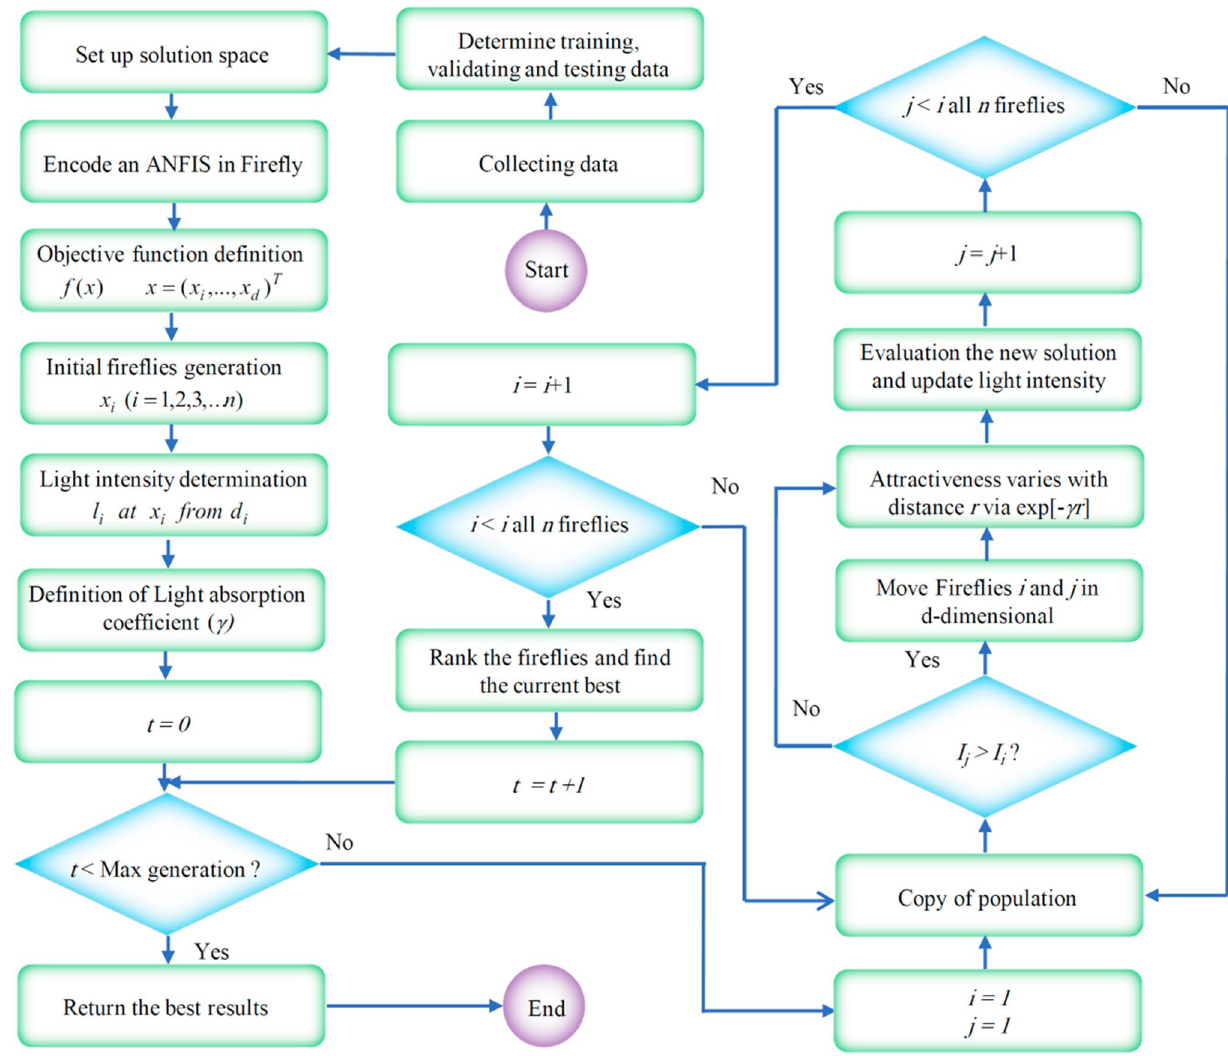
Fig. 2 Flowchart of firefly algorithm used in this